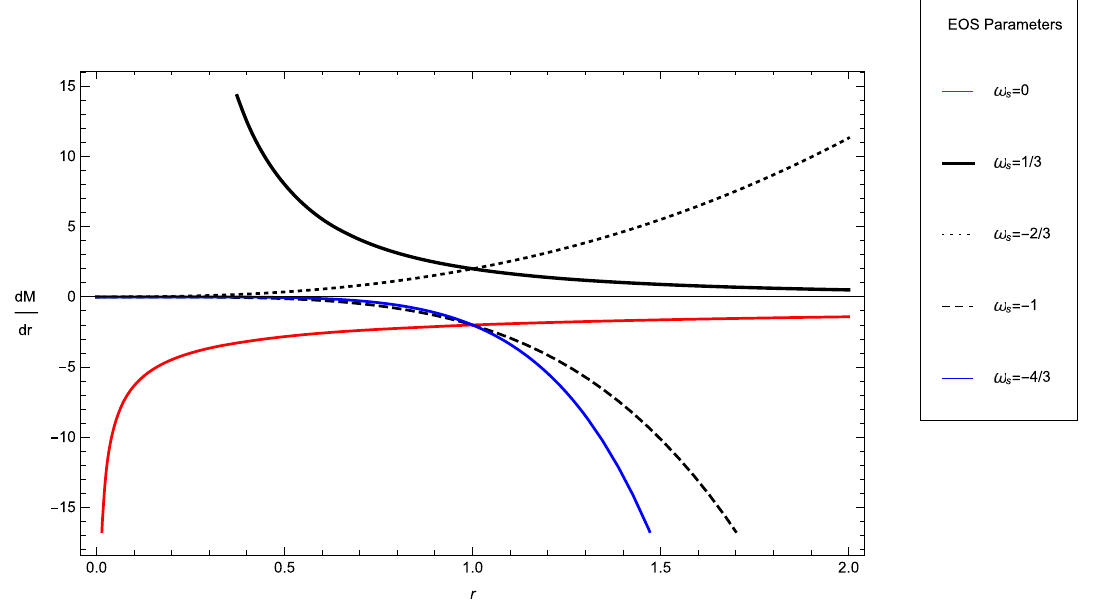
Fig. 3 Plot indicating the evolution of the radial derivative of the mass function with respect to r , for each of the matter field parameters